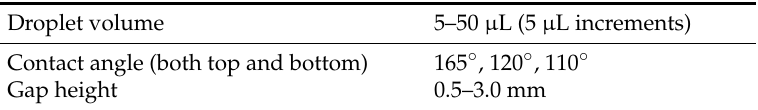
Table 1. Simulation parameters used.